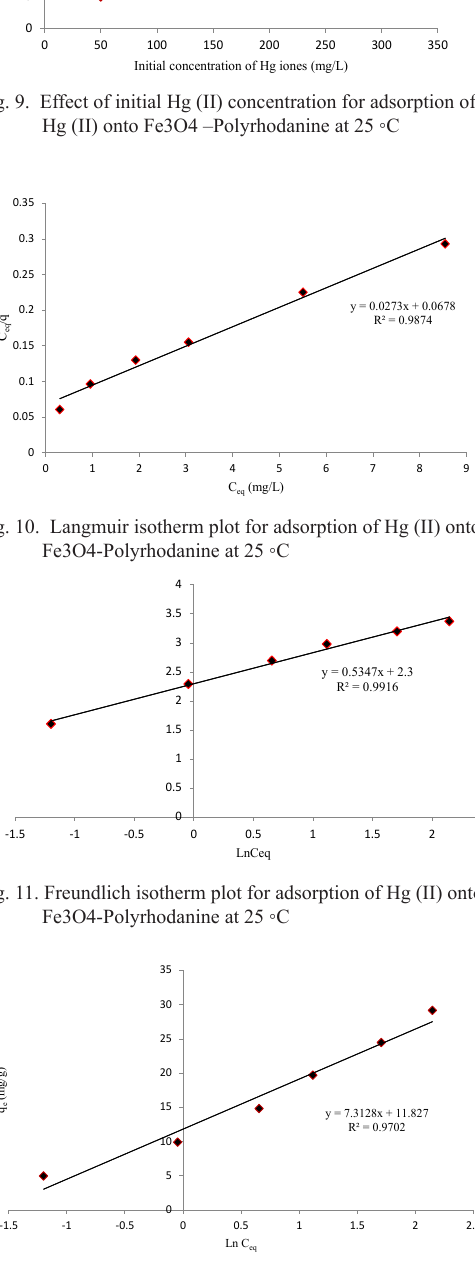
Fig. 12. Temkin isotherm plot for adsorption of Hg (II) onto Fig.12:TemkinisothermplotforadsorptionofHg(II)ontoFe 3 O 4 -Polyrhodanineat25 ◦ C Fe3O4-Polyrhodanine at 25